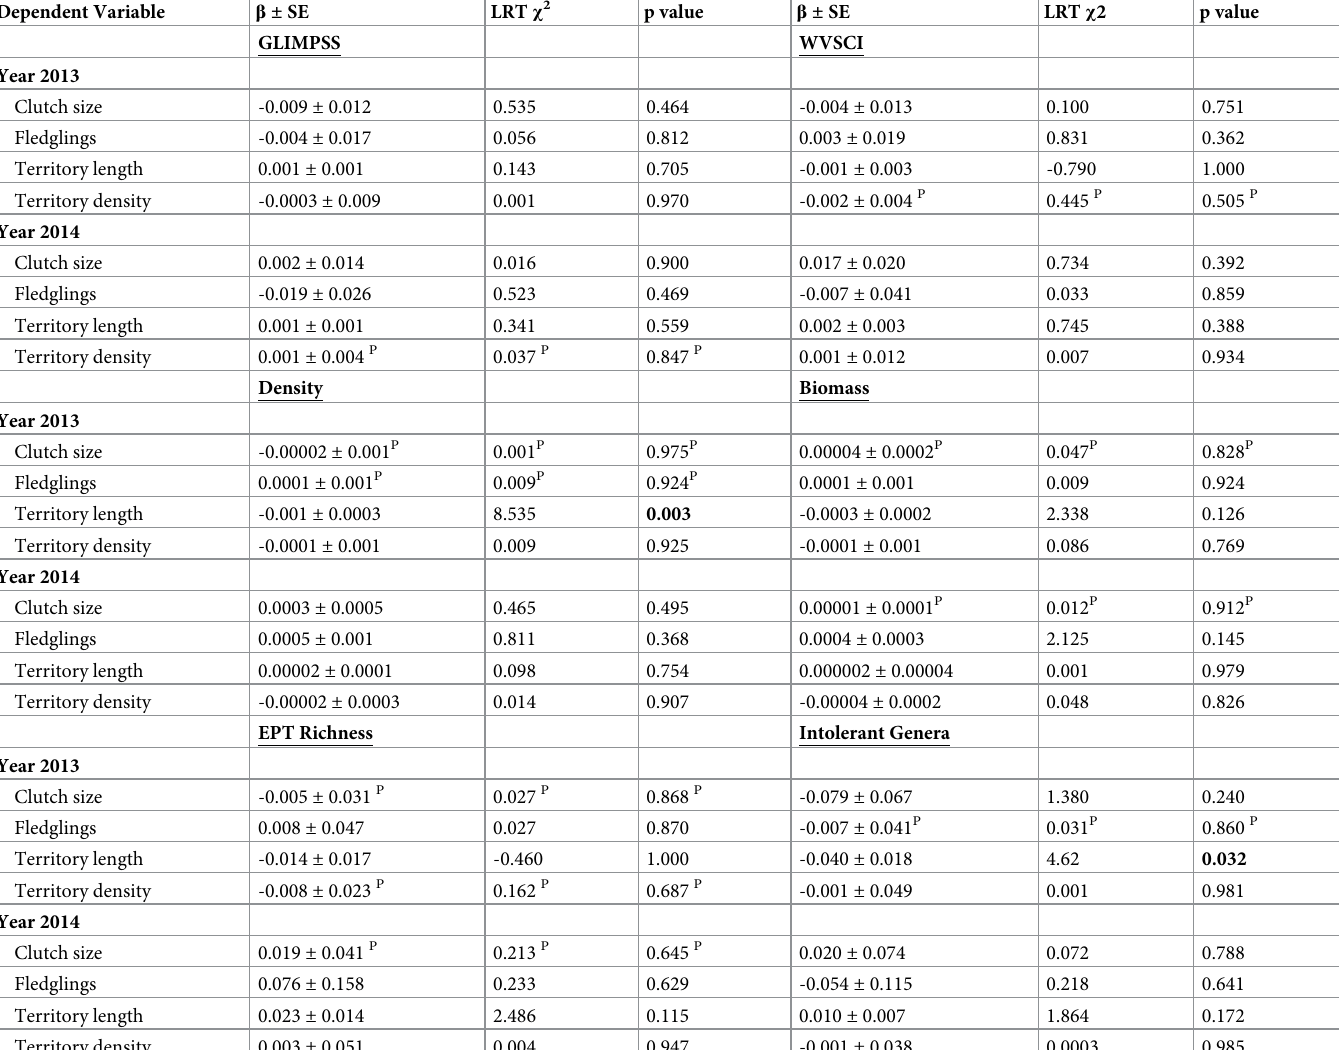
Table 4. Association between waterthrush demographic response (i.e., clutch size, number of fledglings, territory length and territory density) and its aquatic prey in spatial generalized linear mixed models. All tests for the relationships between clutch size, number of fledglings, and territory density with aquatic prey metrics were statistically non-significant. Territory length decreased with increasing aquatic prey density and number of intolerant genera in 2013. Results with P are from a Poisson model. P values of variables that are statistically significant are bolded. Variable names are defined in S2 Table. LRT = likelihood ratio test χ 2 statistic. β = beta estimate of fixed